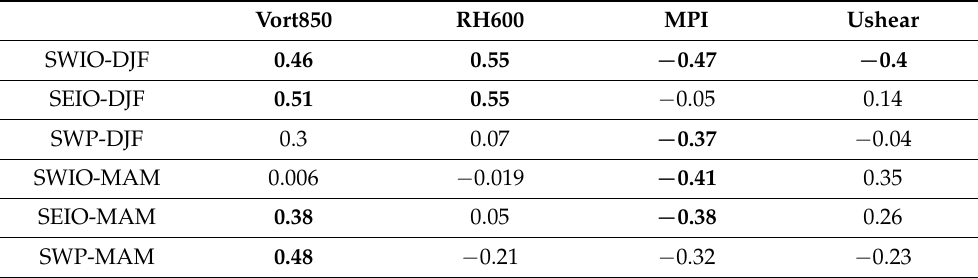
Table 1. Simultaneous correlation coefficients between TCF anomalies and each GPI-related indices. Vort850 and Ushear are sign-reversed so that positive values mean increased GPI. Bold indicates above 90%